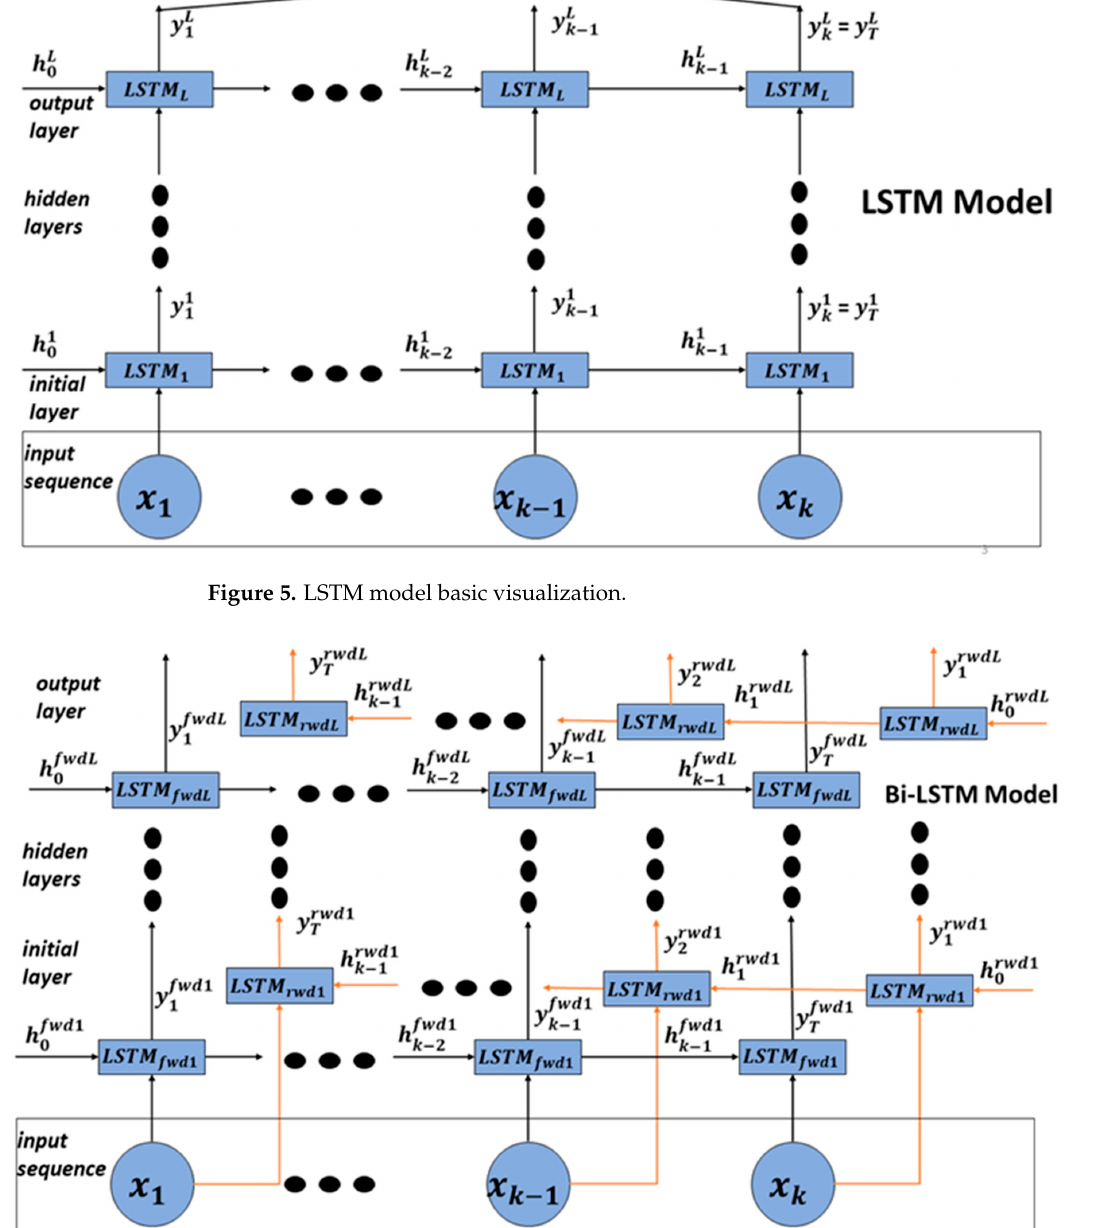
Figure 6. Bi-LSTM model visualization. Two parallel PPG readings are given in this procedure by using raw signals and PPG-based features as inputs.